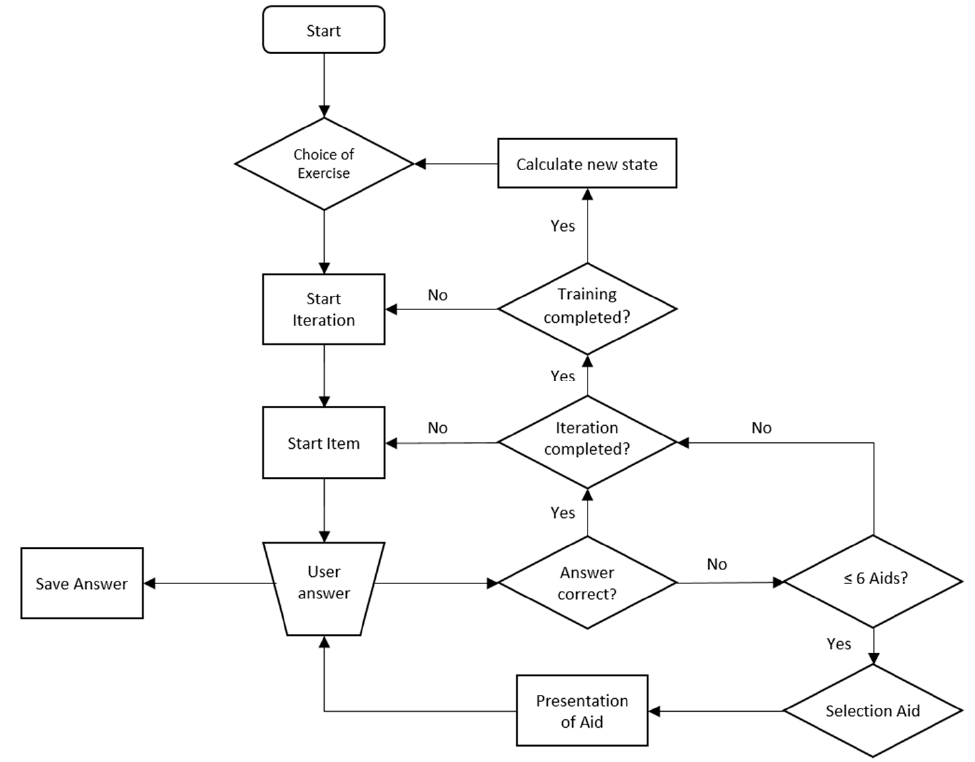
Figure 1. Program procedure plan for an adaptivity algorithm within the exercise.